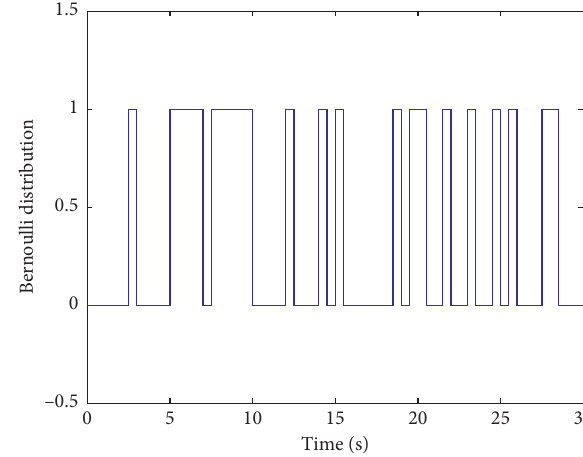
Figure 12: The jump of Bernoulli distribution in Case 4.